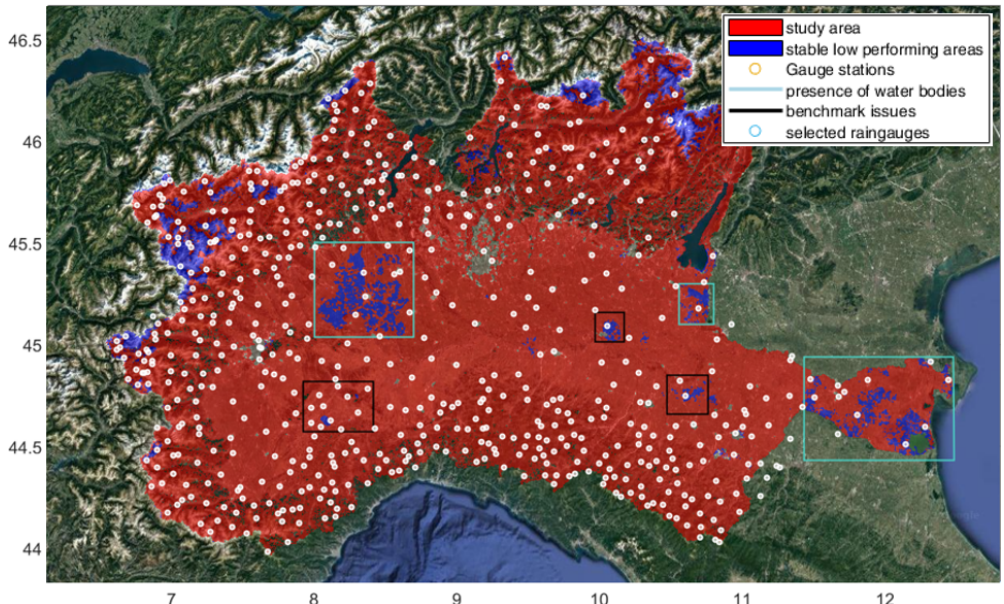
Figure 8. Map of Po River basin. The blue pixels indicate the areas where Pearson’s correlation between the 30d accumulated rainfall from MCM and the calibrated and parameterized SM2RAIN applied to ASCAT or S1-RT1 is stably less than a threshold of 0.65. The light blue rectangles surround the areas with paddy areas or abundant water bodies, while black rectangles outline areas with alleged “bad”-performing gauge stations. Finally, the white dots show the gauge station locations and the green dots the rain gauge selected to be analyzed further. Map copyright © 2021 GeoBasis-De/BKG (© 2009), Google, Inst. Geogr. Nacional Immagini © 2021